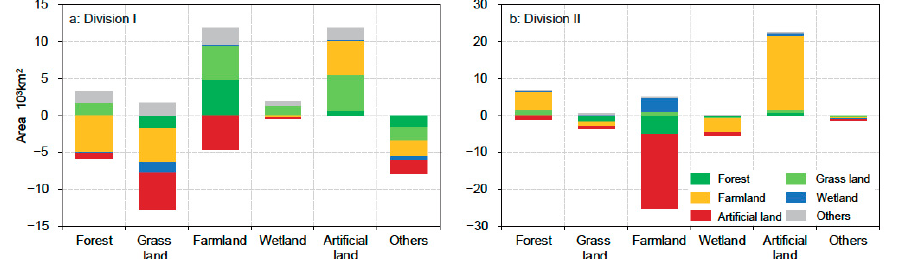
Figure 4. Land-use changes from 2000 to 2015 in Division I ( a ) and Division II ( b ).